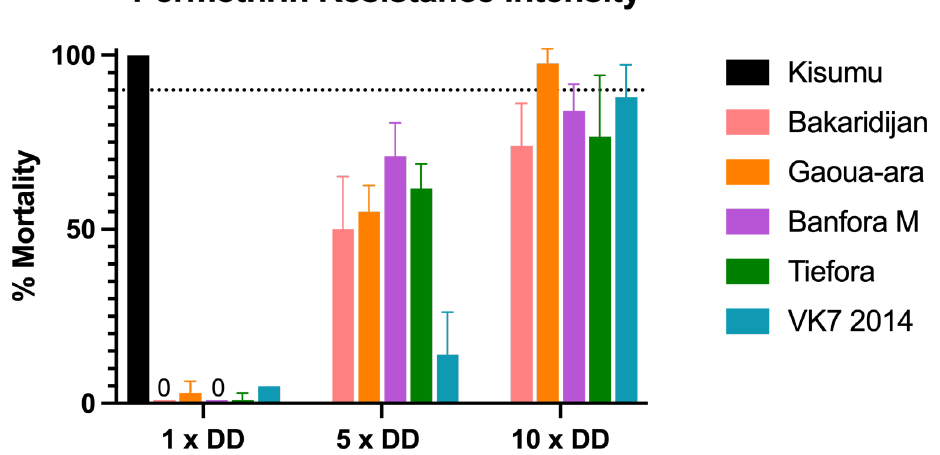
Figure 3. Mosquito mortality following exposure to permethrin papers in WHO resistance intensity assays. Mortality rates (%) 24 h after exposure for 5 strains of Anopheles mosquito. Minimum sample size n = 80. Error bars represent 95% confidence intervals. Dotted line represents the WHO 90% mortality resistance threshold. DD: Diagnostic dose. All strains showed significant synergism when pre-exposed to PBO followed by a 4-h exposure to permethrin but synergism was not consistently observed with shorter pyre- throid exposures and PBO pre-exposure did not fully restore susceptibility to permethrin in any of the strains (Figure 4; full mortality results and synergism ratios are available in Sup- plementary Table S1). The highest synergist ratios were seen for Banfora where significant synergism was observed at all permethrin exposures greater than 2 h and PBO:permethrin synergism ratios ranged from 7:1 (2 h) to 54:1 (3 h). Negative controls (both control papers only and PBO followed by control papers) gave <4% mortality in all assays.